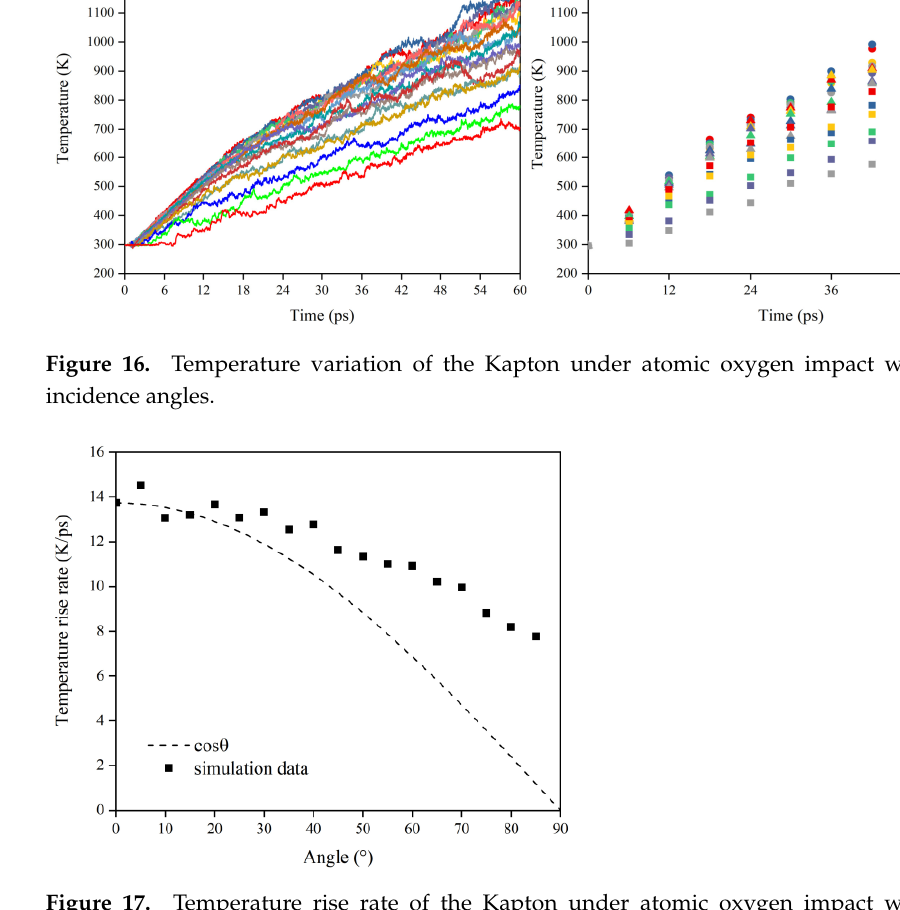
Figure 17. Temperature rise rate of the Kapton under atomic oxygen impact with different incidence angles.